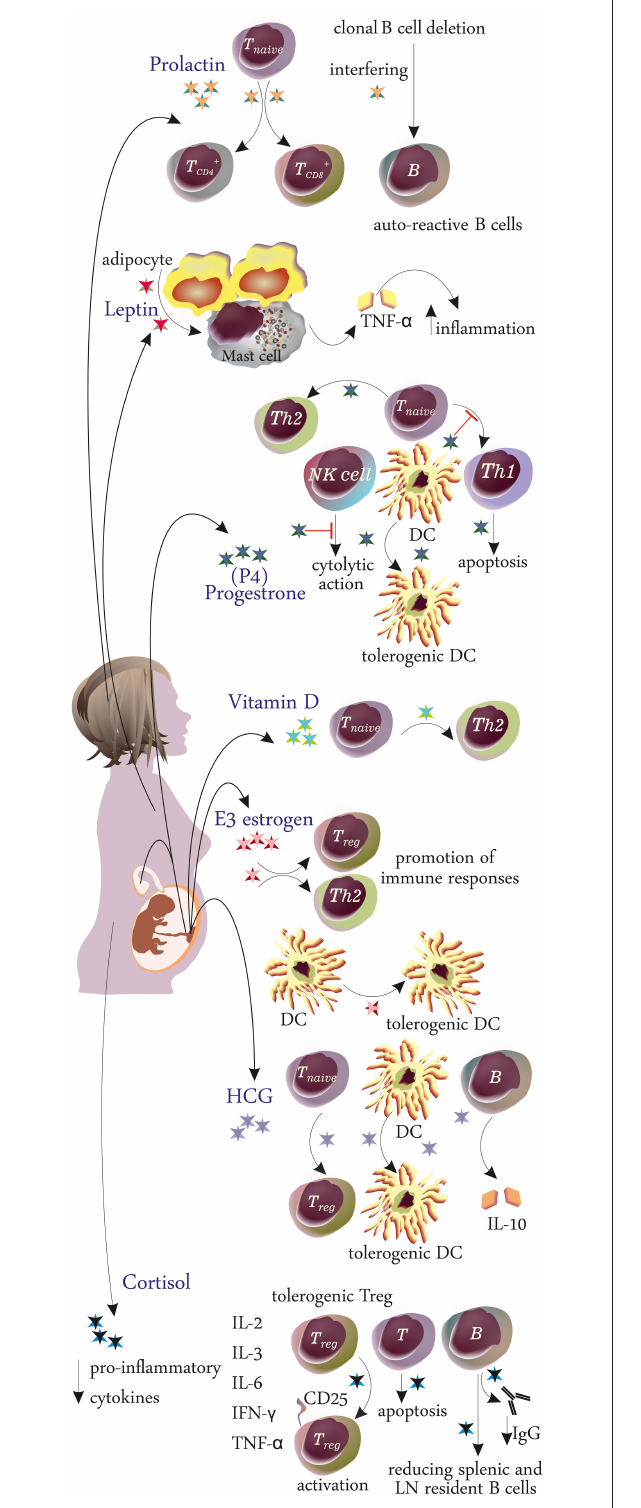
FIGURE 3 | Changes in innate immunity during pregnancy. (A) Dendritic cells, monocytes, macrophages, mast cells. (B) Cytokines. (C) TH1/TH2 shift. (D) Natural killer